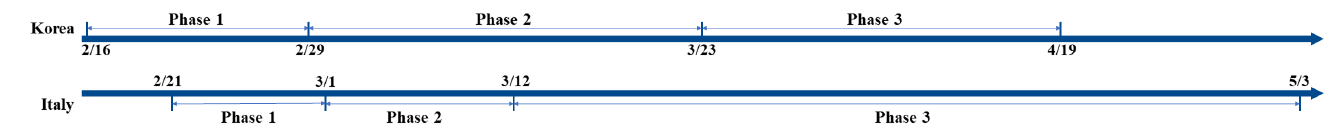
Figure 2. Timeline of COVID-19 intervention policies in Korea ( top ) and Italy ( bottom